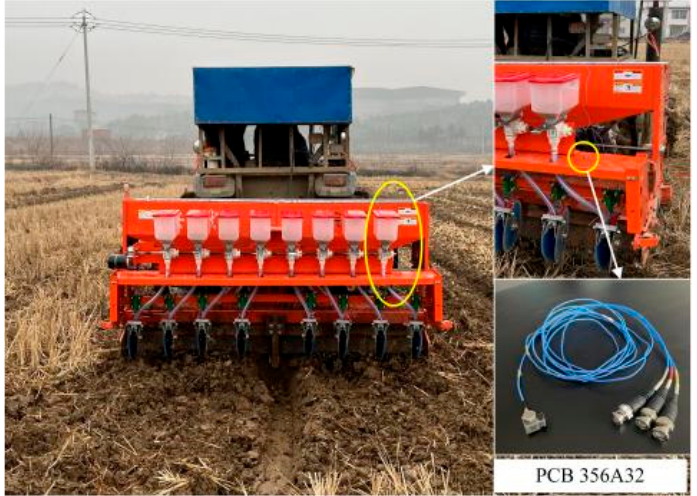
Figure 6. Vibration test and sensor installation position of inverted-fin-shaped model-hole-wheel variable seed metering device for wheat.